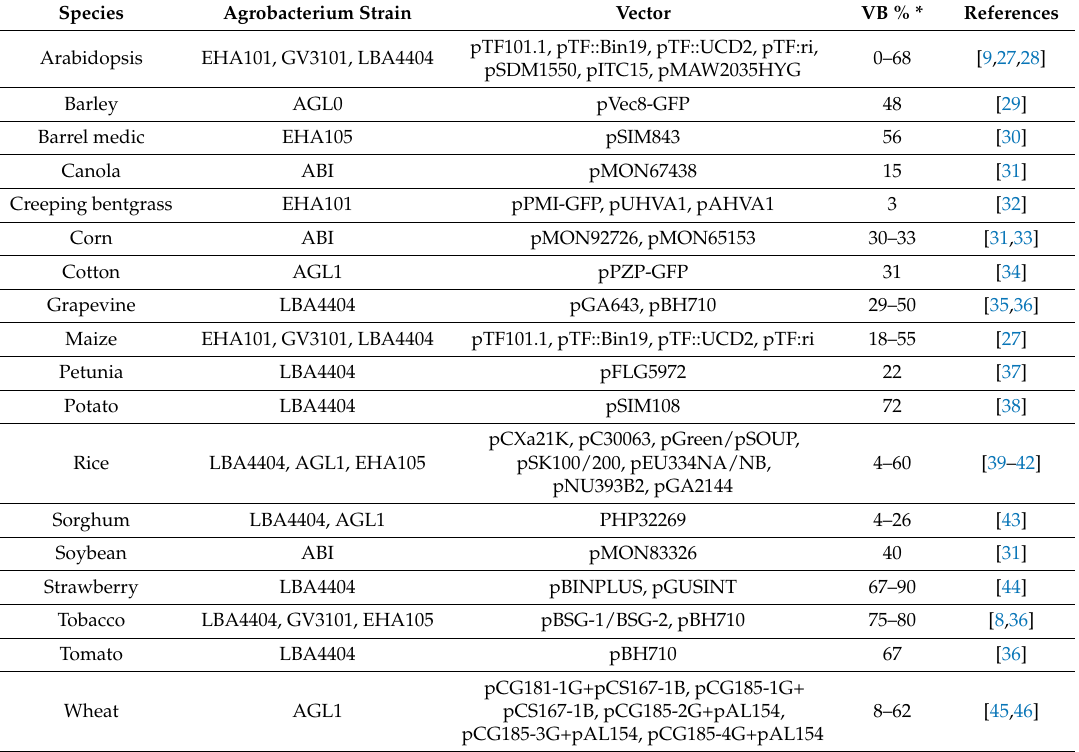
Table 1. Percentages of transgenic events containing vector backbone (VB) sequences in different plant